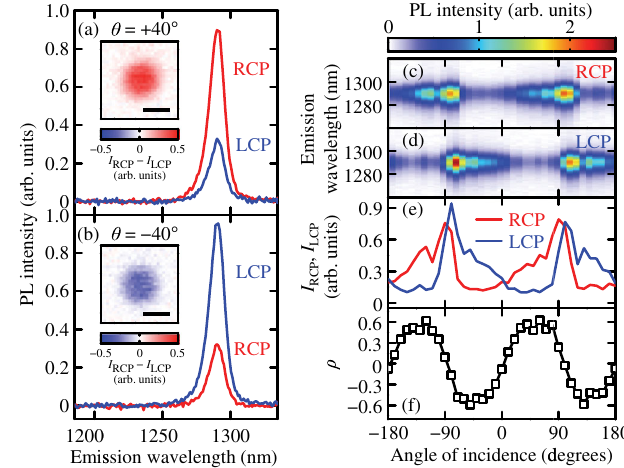
FIG. 3 (color online). (a) and (b) PL spectra taken at θ ¼ þ 40 ∘ and − 40 ∘ , respectively, with RCP (red) and LCP (blue). The insets show the difference images. Scale bars are 2 μ m. (c) and (d) In-plane angle dependence of PL spectra for RCP and LCP, respectively. (e) I (red) and I (blue) as a function of θ . RCP LCP (f) Polarization calculated from data in (e). Data are taken at λ ¼ 780 nm and P ¼ 2 mW on a 0.9- μ m-long